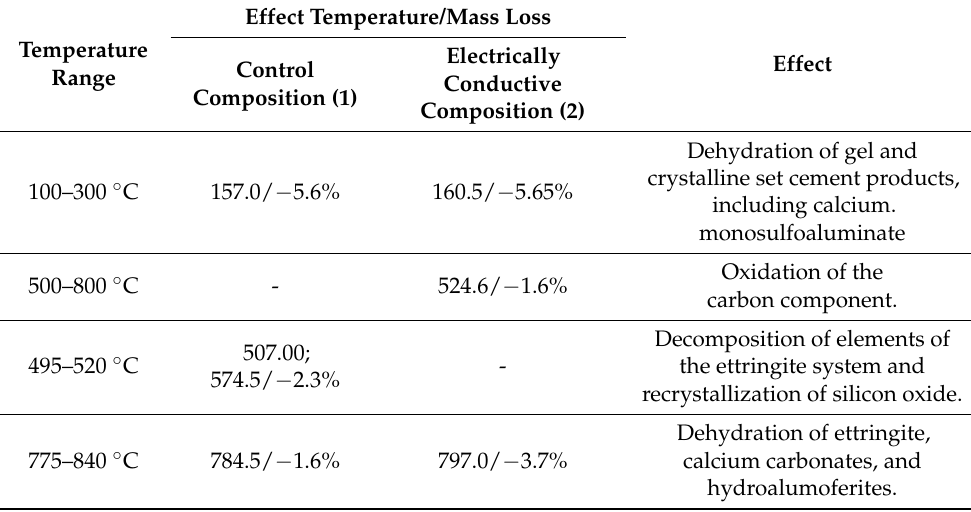
Figure 5. DSC analysis of samples on day 224 of the test: 1—control composition; 2—electrically conductive composition. Table 4. Temperature effects of control and electrically conductive